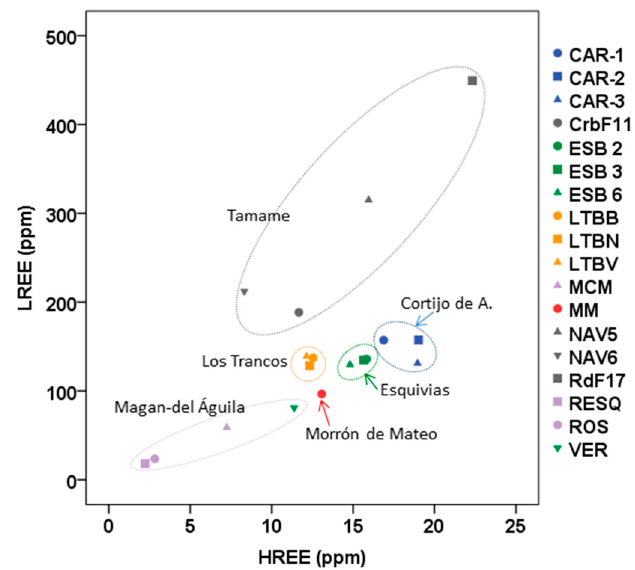
Figure 11. LREEs (light rare earth elements) versus HREEs (heavy rare earth elements).